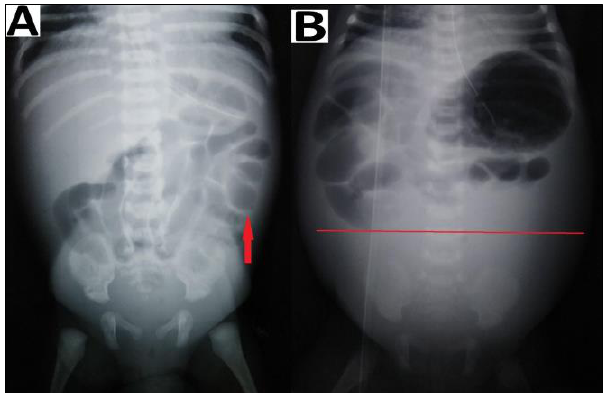
Figure 4: Preoperative radiographs showing: (A) increased bowel wall thickening (red arrow) and (B) dilated small bowel loops in the upper abdomen with ground glass appearance in the lower abdomen (below the red line).